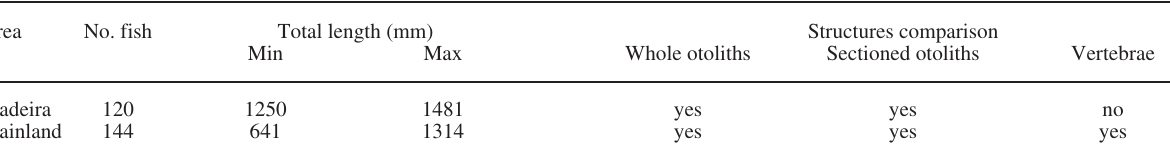
Table 1. – origin, number and length range of specimens of Aphanopus carbo used for the comparison of ageing structures (whole and